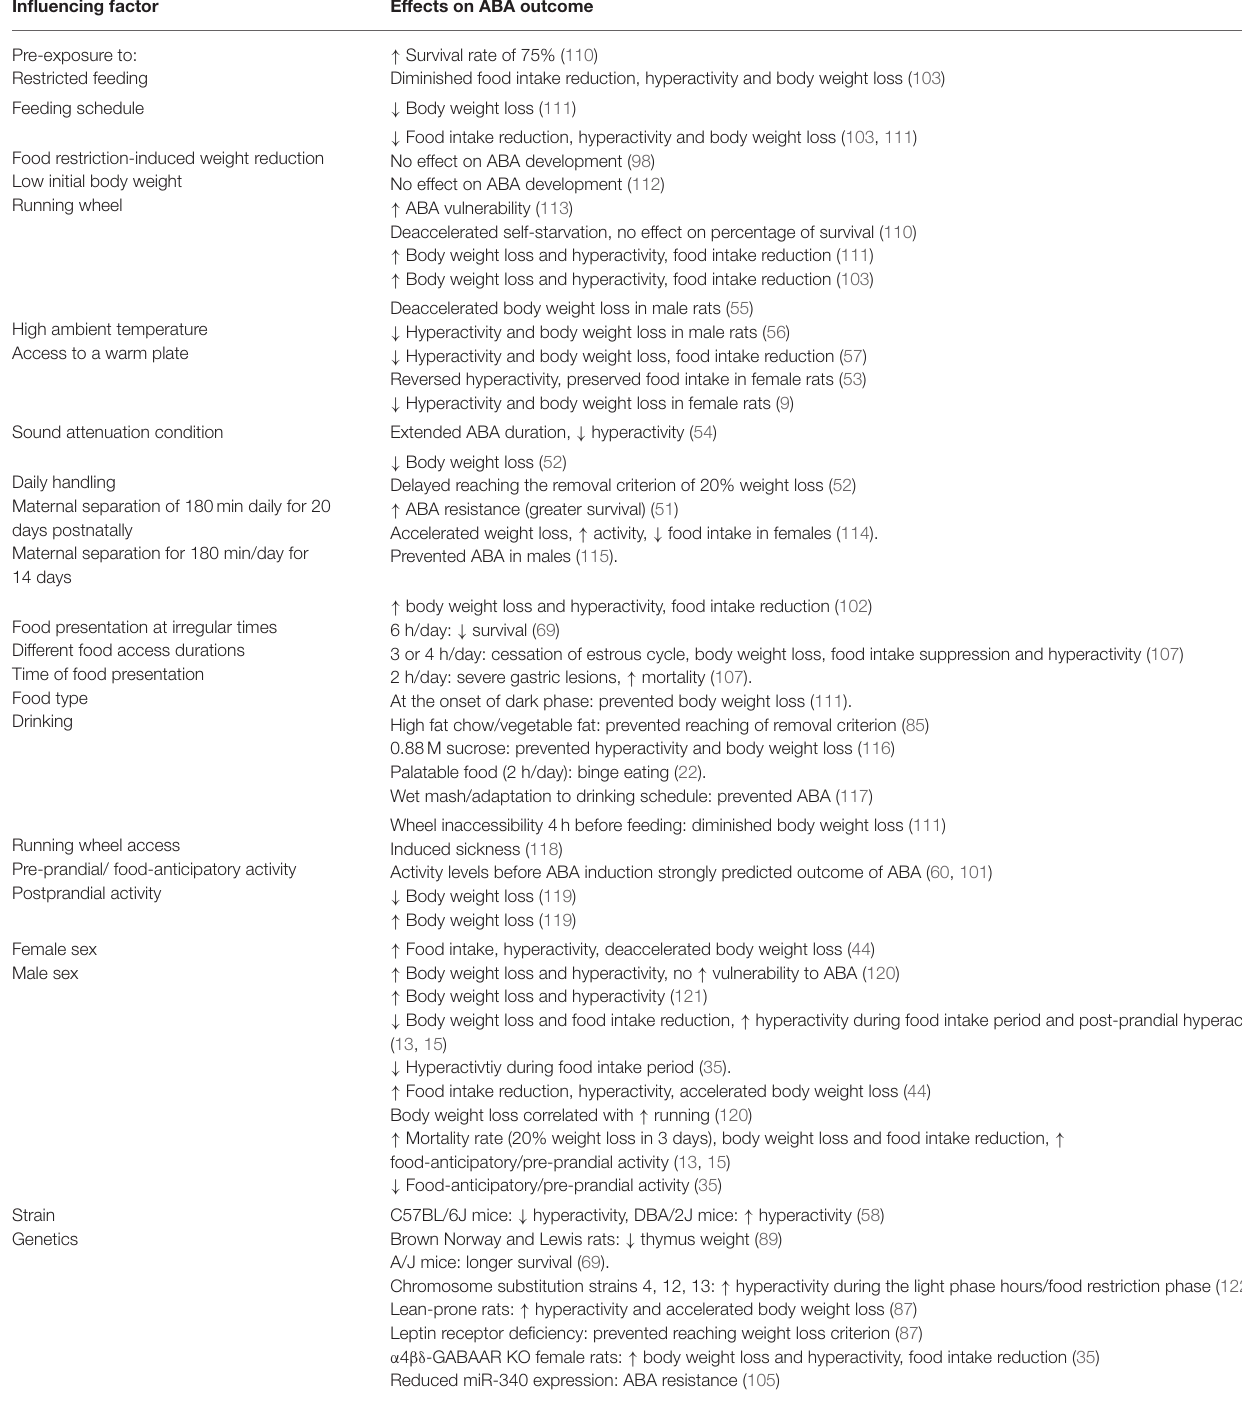
TABLE 2 | Factors influencing ABA outcome. Influencing factor Effects on ABA outcome Pre-exposure to: Restricted feeding Feeding